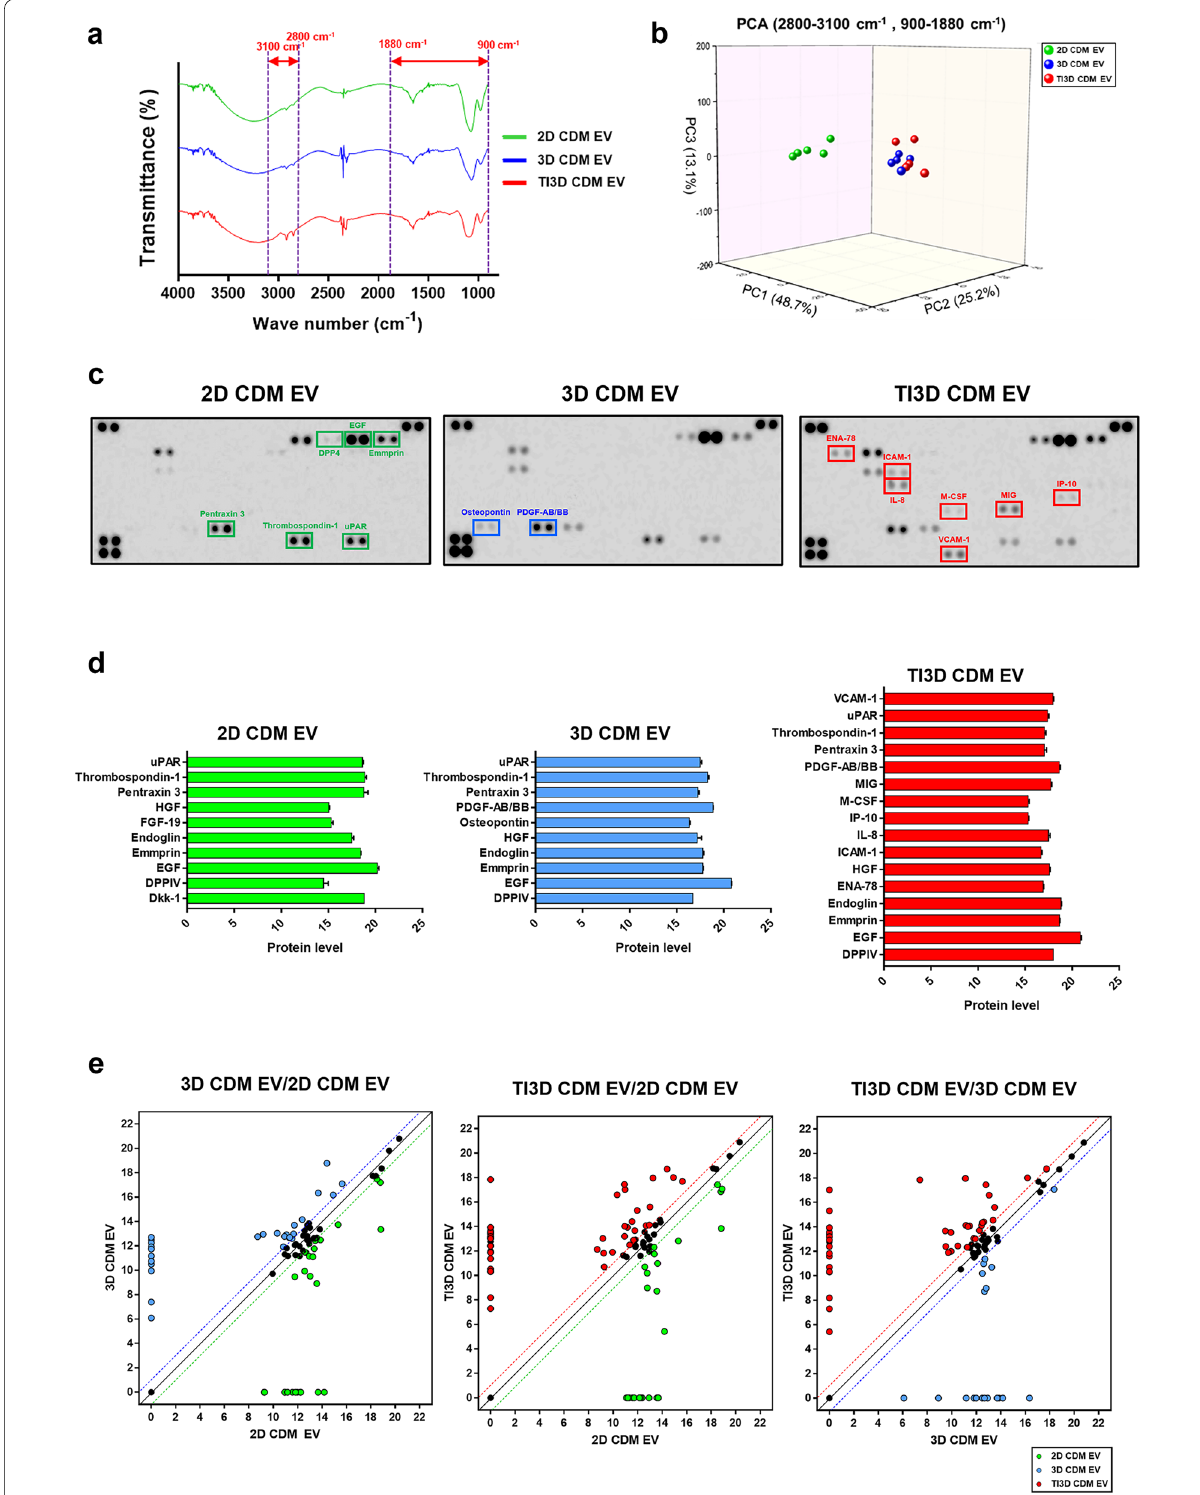
Fig. 3 Internal and external characteristics of EVs. a The FTIR spectra of EVs in the range of 900–4000 cm − 1 wavelength to distinguish the surface compositions of EVs. b The 3D PCA score plot to classify EVs from FTIR analysis. c The representative images of cytokine array membranes of 2D CDM EV, 3D CDM EV, and TI3D CDM EV. d The comparison of expression levels for representative cytokines. e The scatter plot of three different EVs by the results of cytokine